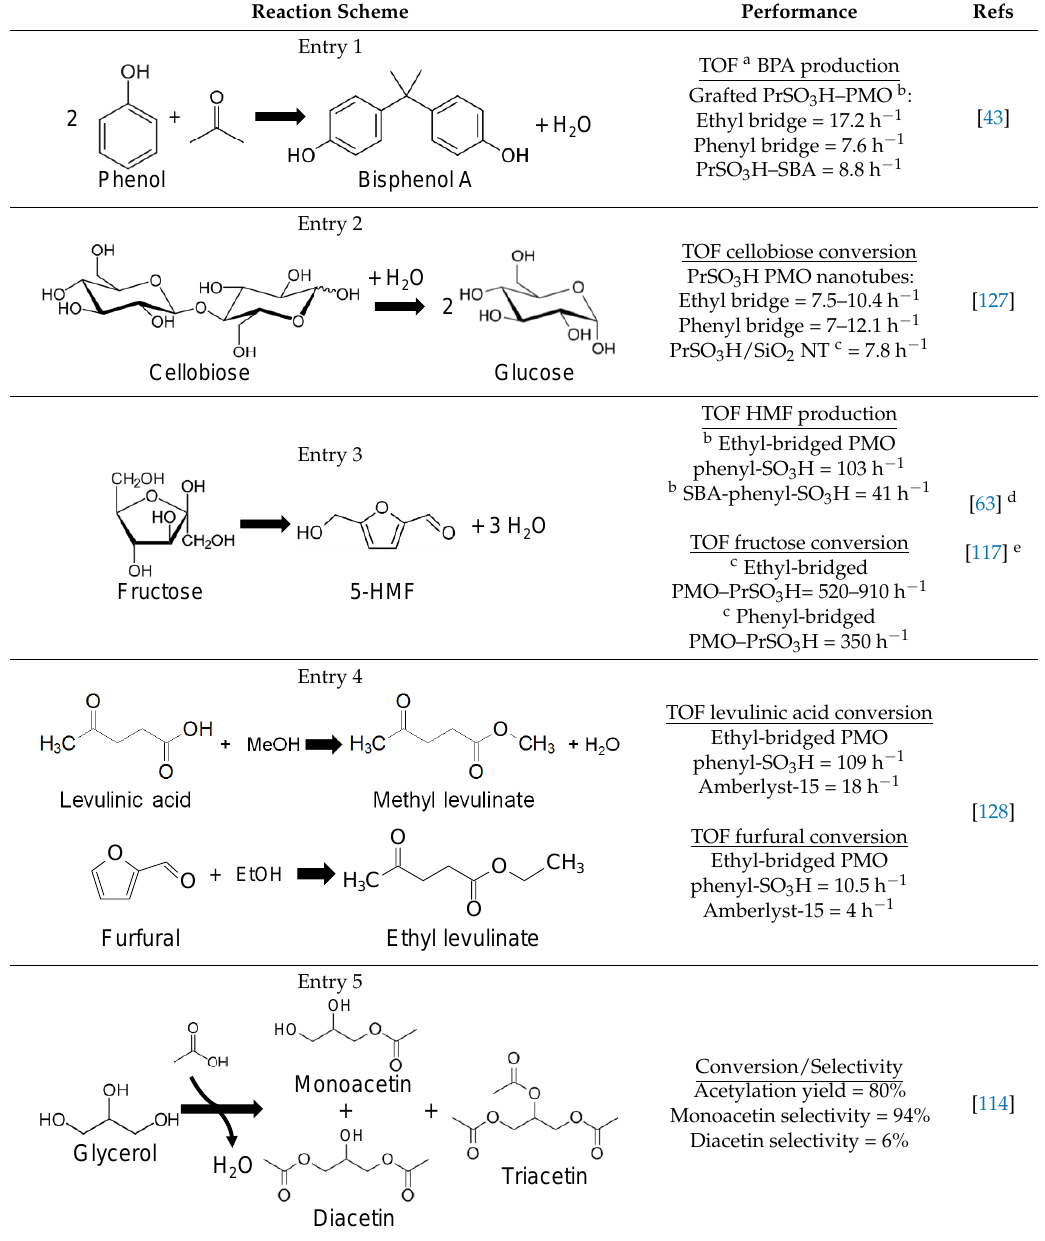
a TOF=Turnover frequency; b PrSO 3 H=propyl sulfonic acid; c NT=nanotube; d productivity estimated from S content in dimethyl sulfoxide (DMSO) at 120 C; e water with Methyl isobutyl ketone (MIBK)/2- butanol (70/30) at 160 °C.